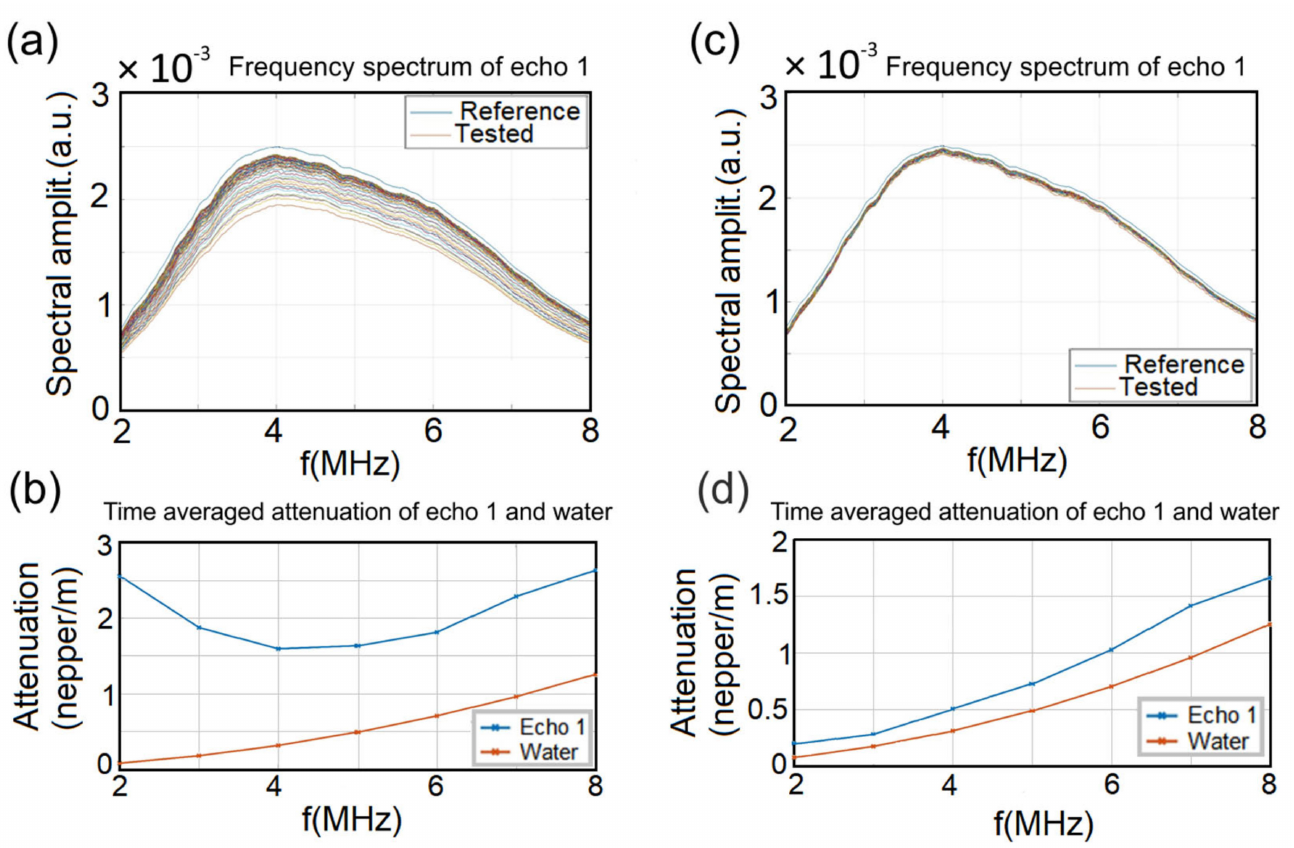
Figure 10. Frequency spectrum of echo 1 before ( a ) and after lead removal ( c ). Time averaged attenuation of echo 1 and water before ( b ) and after lead removal ( d